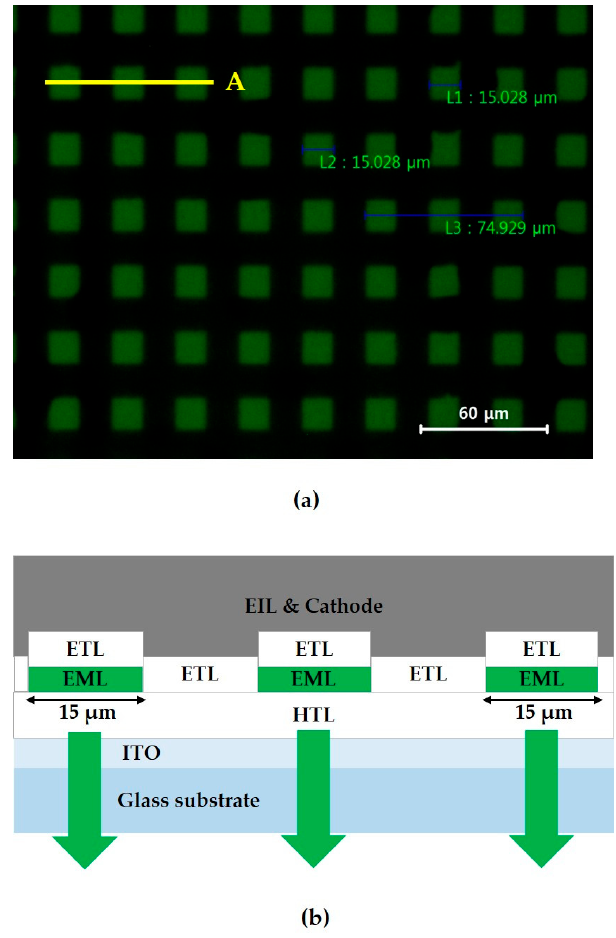
Figure 7. ( a ) Optical micrograph of the 15 μ m green-emitting pixel array during the OLED operation; ( b ) stack structure of the OLED indicated by the segmental line A in picture (a).